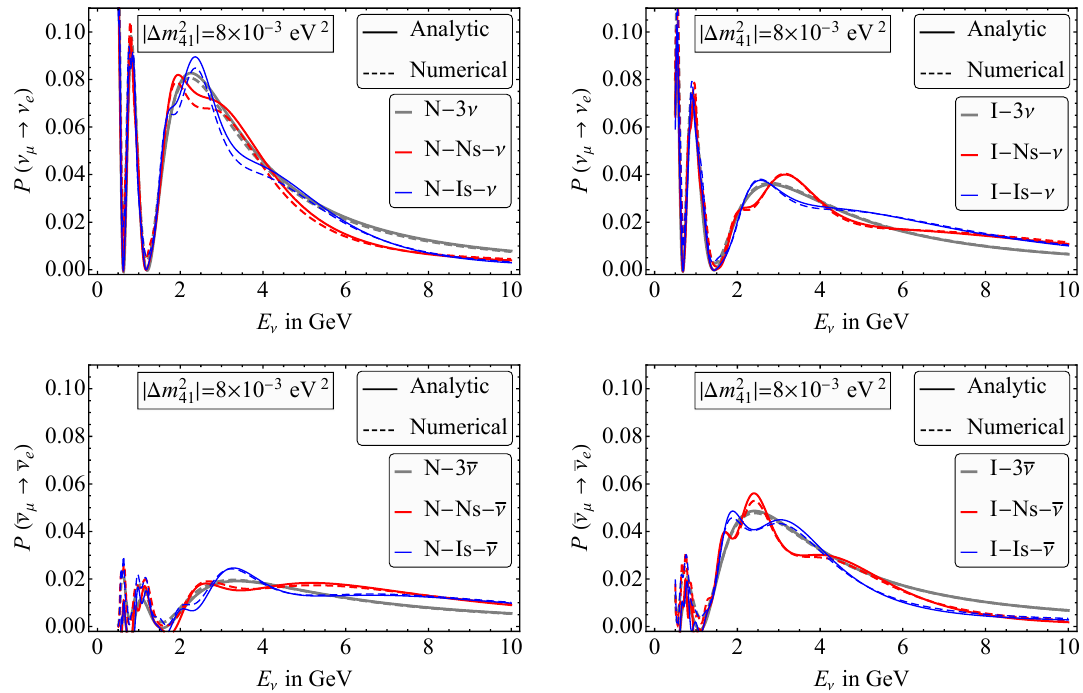
Figure 3 . Conversion probabilities P ( ν µ → ν e ) [Top panels] and P (¯ ν µ → ¯ ν e ) [Bottom panels] as functions of energy ( E ) for L = 1300 km, for the mixing parameters given in eqs. (2.20)–(2.21) ν and for | ∆ m 2 | = 8 × 10 − 3 eV 2 . Left and Right panels correspond to Normal and Inverted mass 41 ordering, respectively, in the active